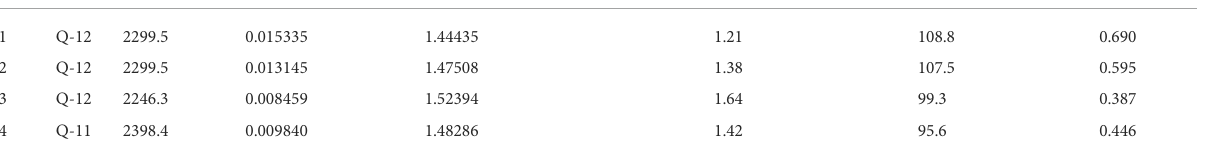
TABLE 3 Dissolved CH 4 in NaCl aqueous inclusions obtained by Raman quantitative analysis.